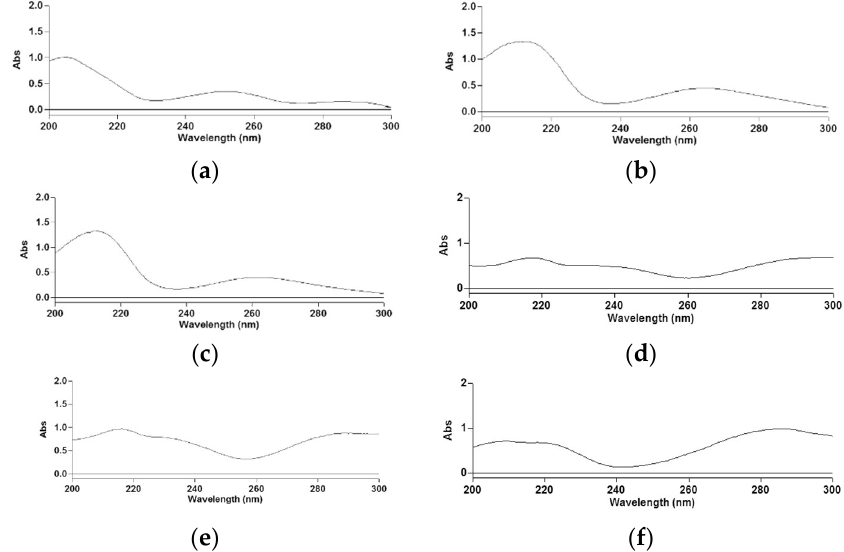
Figure 1. Absorption spectra of vanillic ( a ), syringic ( b ), gallic ( c ), caffeic ( d ), ferulic ( e ) and p - coumaric ( f ) acids.